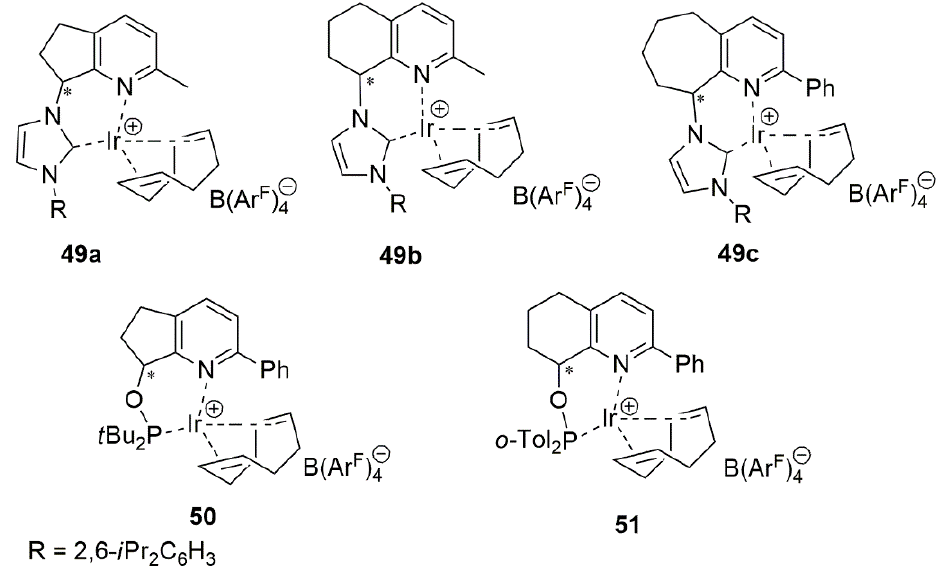
Figure 4. NHC ‐ pyridine type chelating ligands and their iridium complexes [127]. Figure 4. NHC-pyridine type chelating ligands and their iridium complexes